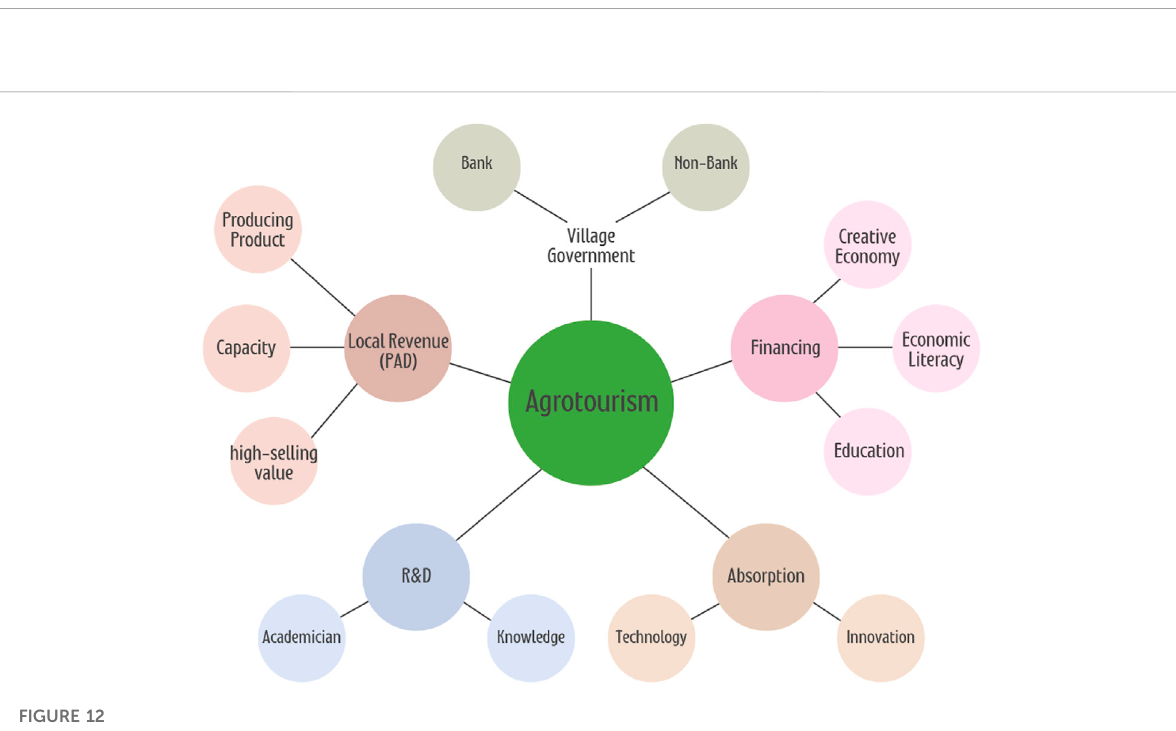
FIGURE 12 Overview of agrotourism in Cibodas